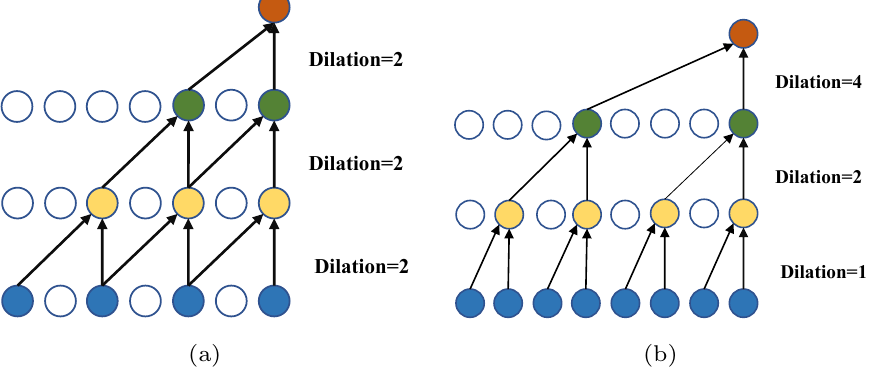
Figure 5. Illustration of the gridding problem. Dilated casual convolution with kernel size 2. ( a ) all convolutional layers have a dilation rate d = 2. ( b ) subsequent convolutional layers have dilation rates of d = 1, 2, 4, respectively.